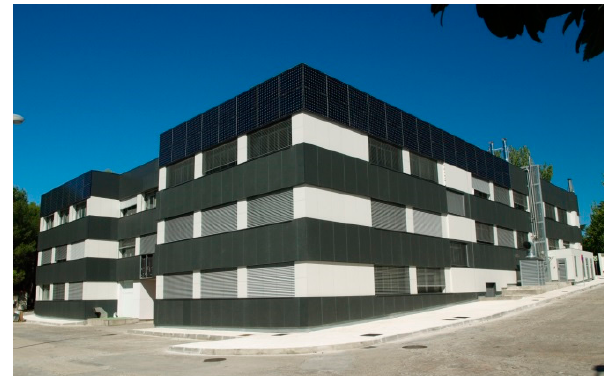
Figure 2. Southwest view of the building after the retrofit.